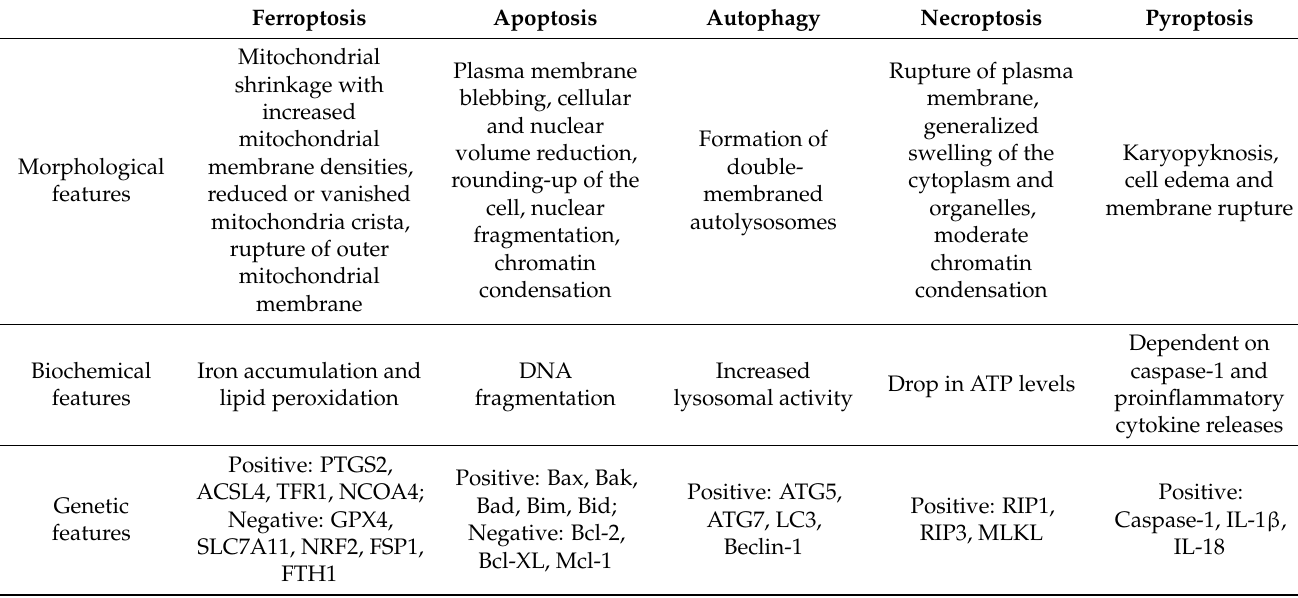
Table 1. Characteristics of ferroptosis, apoptosis, autophagy, necroptosis and